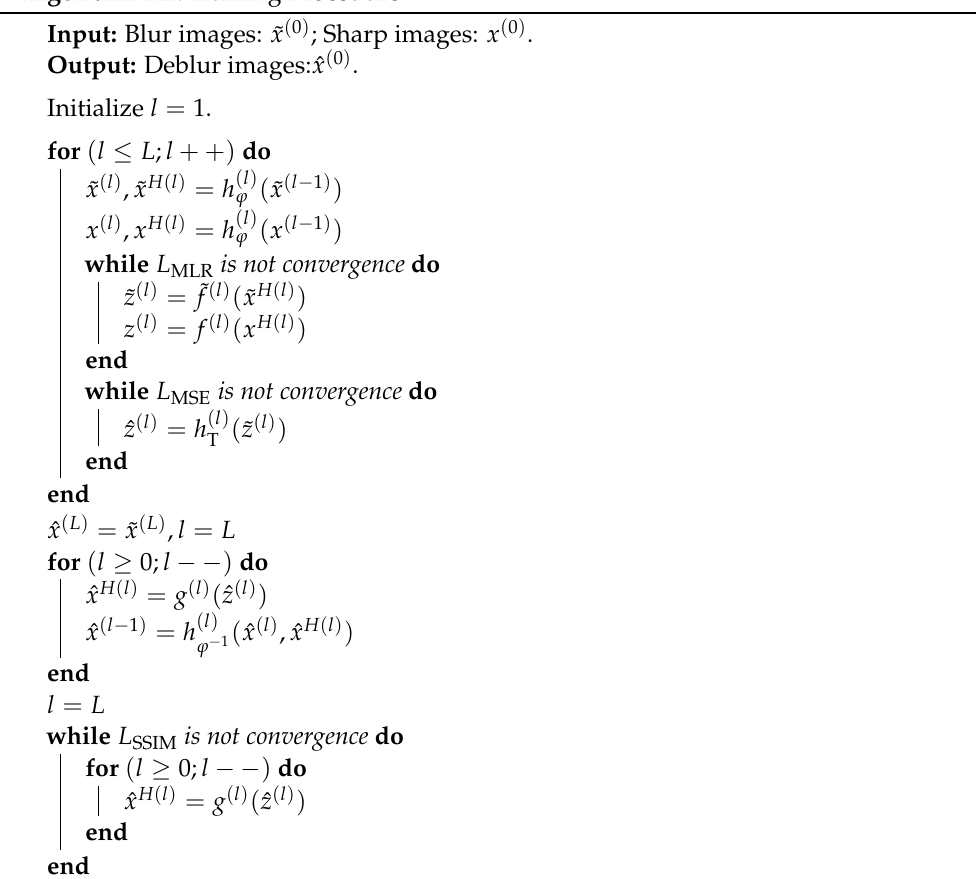
Algorithm A1: Training